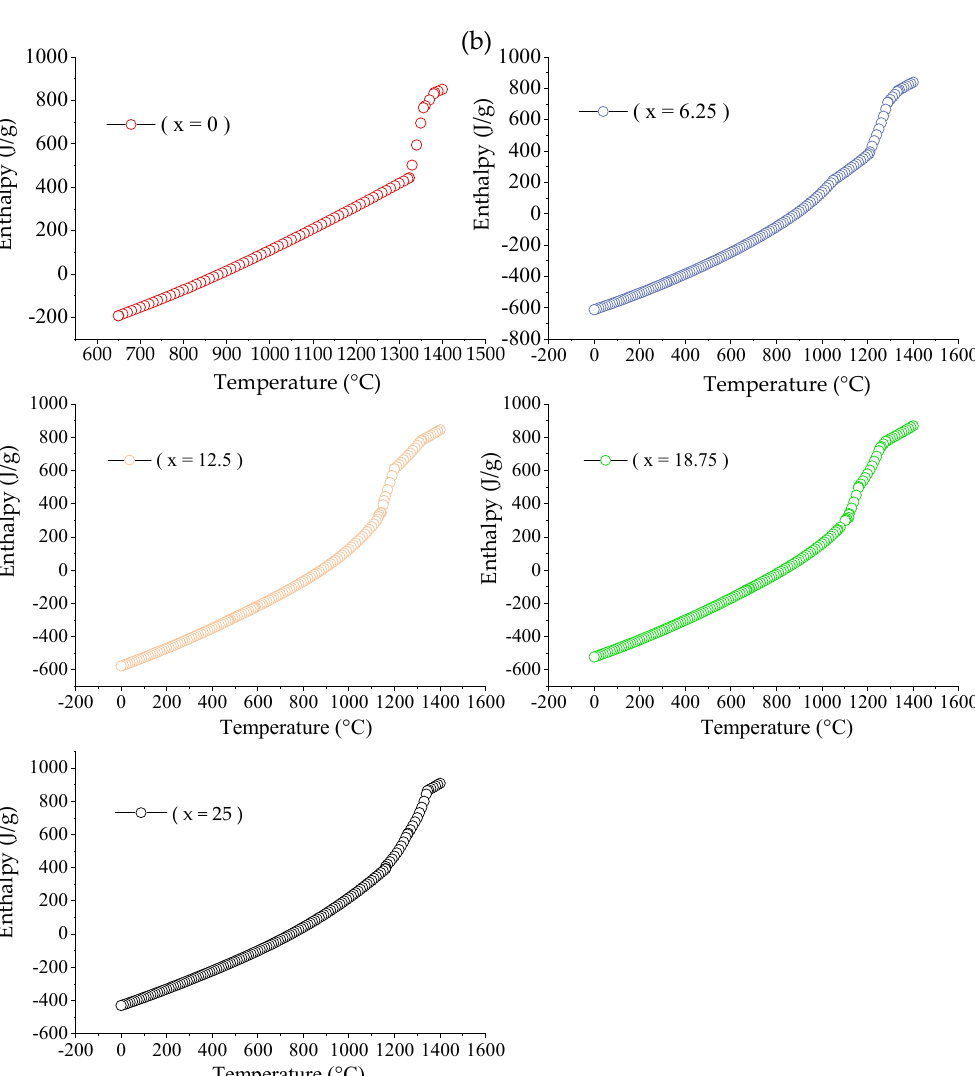
Figure 7. Enthalpy of mixing Δ H mix ( a ) and entropy of mixing Δ S mix ( b ) calculation for Fe 25 Cr 25 Ni 25 Ti x Al (25 − x) multi-principal element alloys.